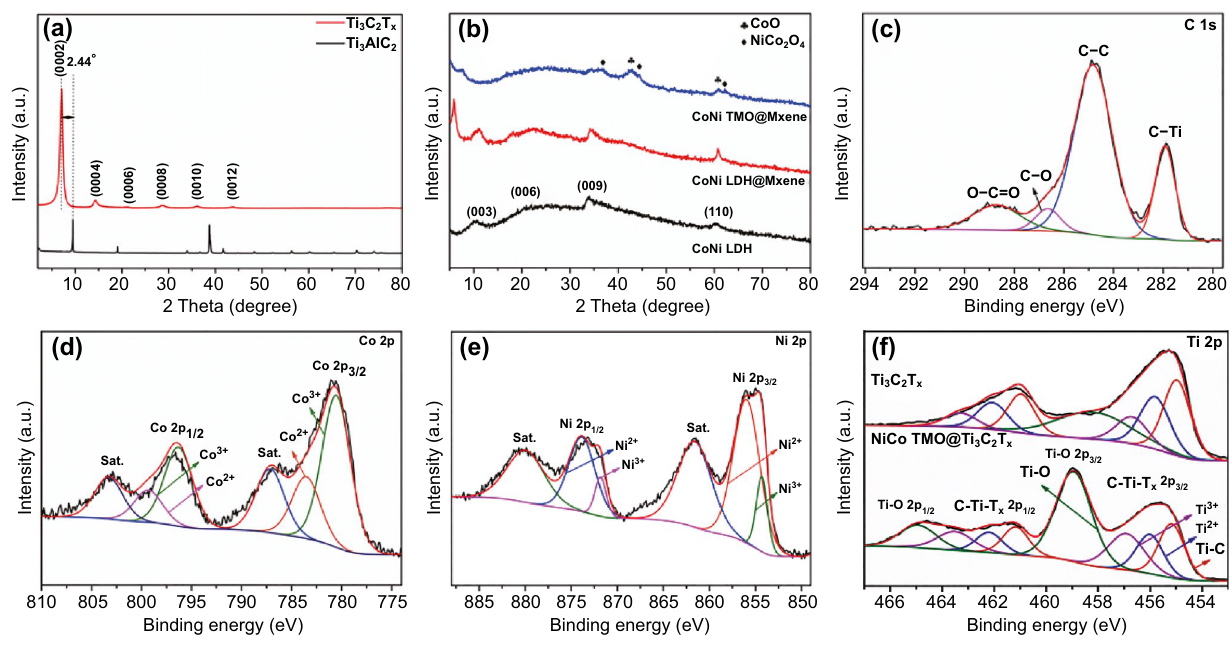
Fig. 5 a , b XRD patterns of as‑prepared samples, c C 1s, d Co 2p, e Ni 2p, and f Ti 2p spectra of TMOT and Ti 3 C 2 T